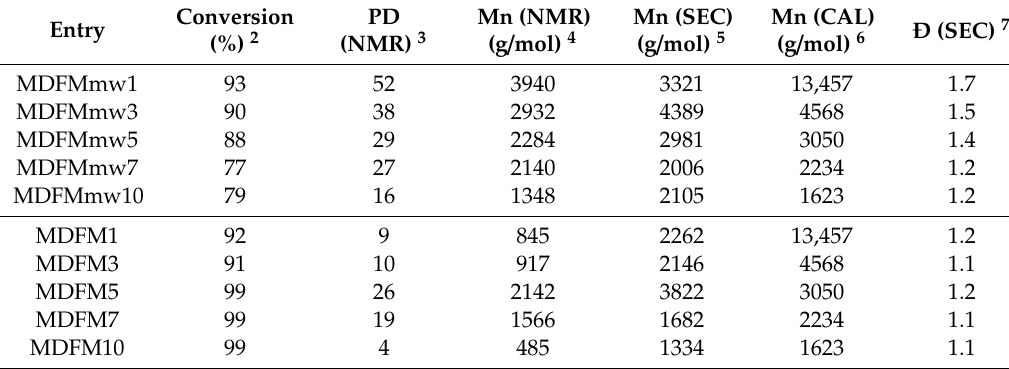
Table 4. Conversion of L-lactide to MDs, PD, Mn determined by 1 H-NMR and by SEC, Mn calculated on the basis of L-lactide / initiator in the feed, and Ð determined by SEC.